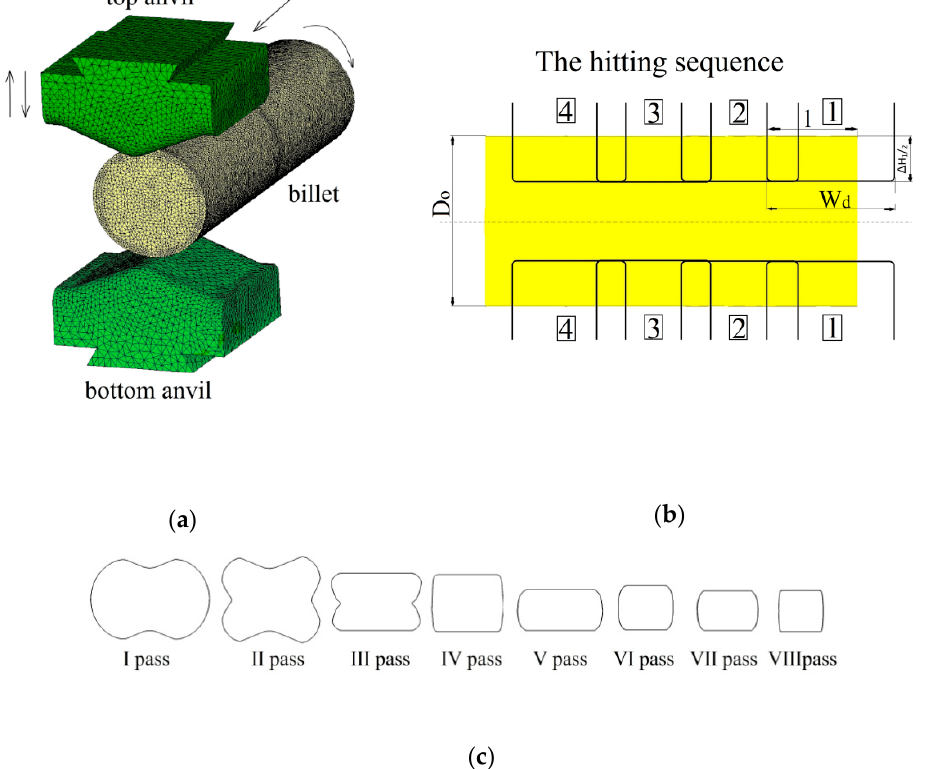
Figure 3. Schematic illustration of the cogging process: ( a ) finite element model for the forging experiment, ( b ) the hitting sequence on the ingot length (l/w d = 0.70; l/D 0 = 0.75), and ( c ) pass sequence for flat anvils (90° rotation).